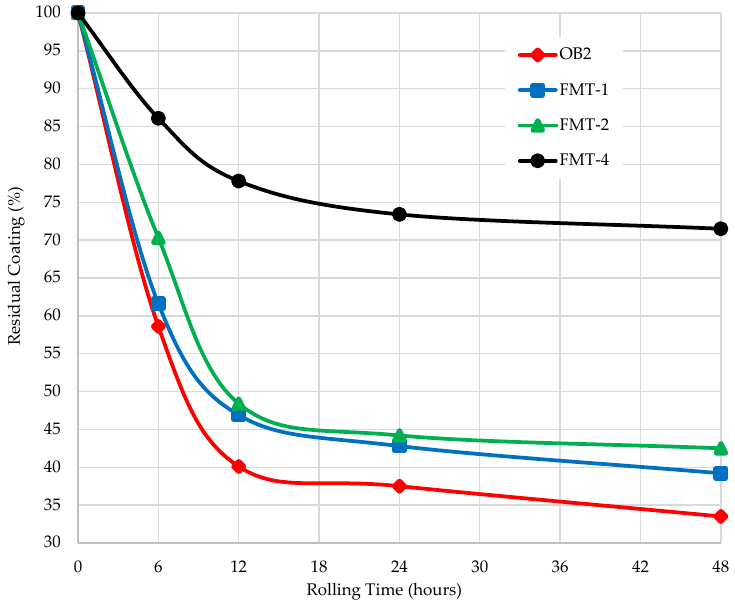
Figure 14. Results of the rolling bottle tests with S1.